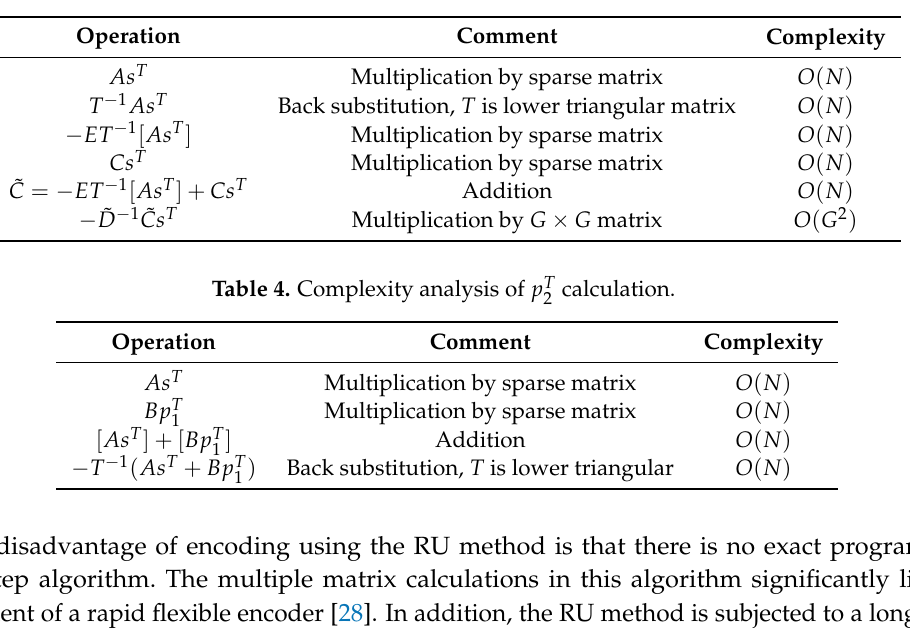
Table 3. Complexity analysis of p T